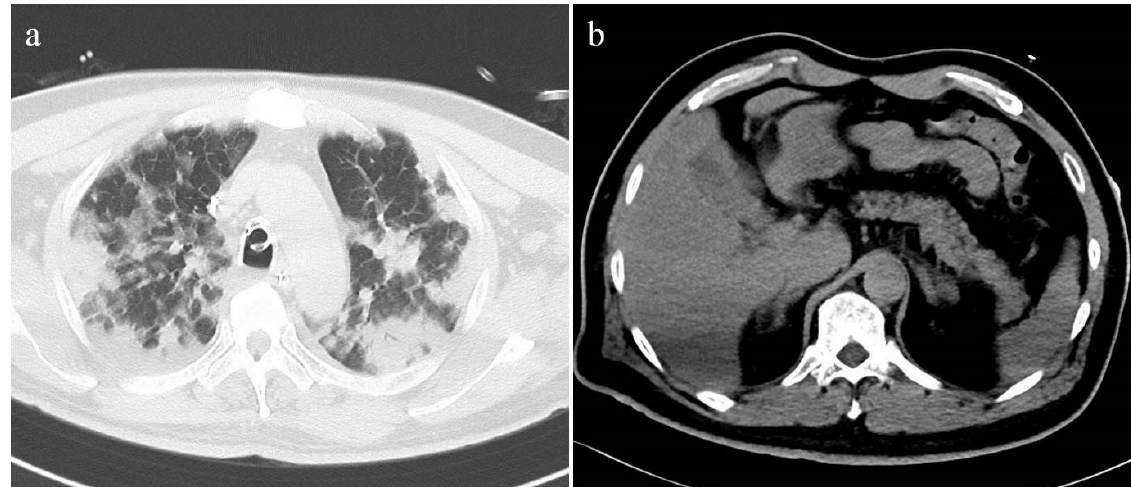
Figure 3. Unenhanced axial CT images of a 51-year-old male patient with severe COVID-19 pneumonia. ( a ) Chest CT showed extensive consolidations in both lungs. The lung severity score was 3.8. ( b ) Pancreatic steatosis and fatty liver were seen on the abdominal CT. The CT-FVF of the pancreas was 28.4% and the CT attenuation value of the liver was 46.9 HU.